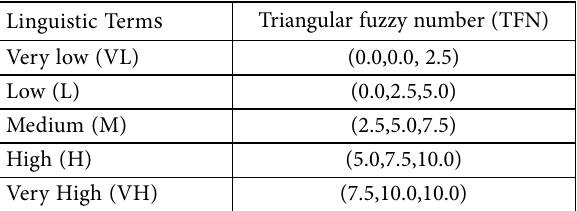
Table 3. Linguistic terms for rating alternatives with respect to criteria